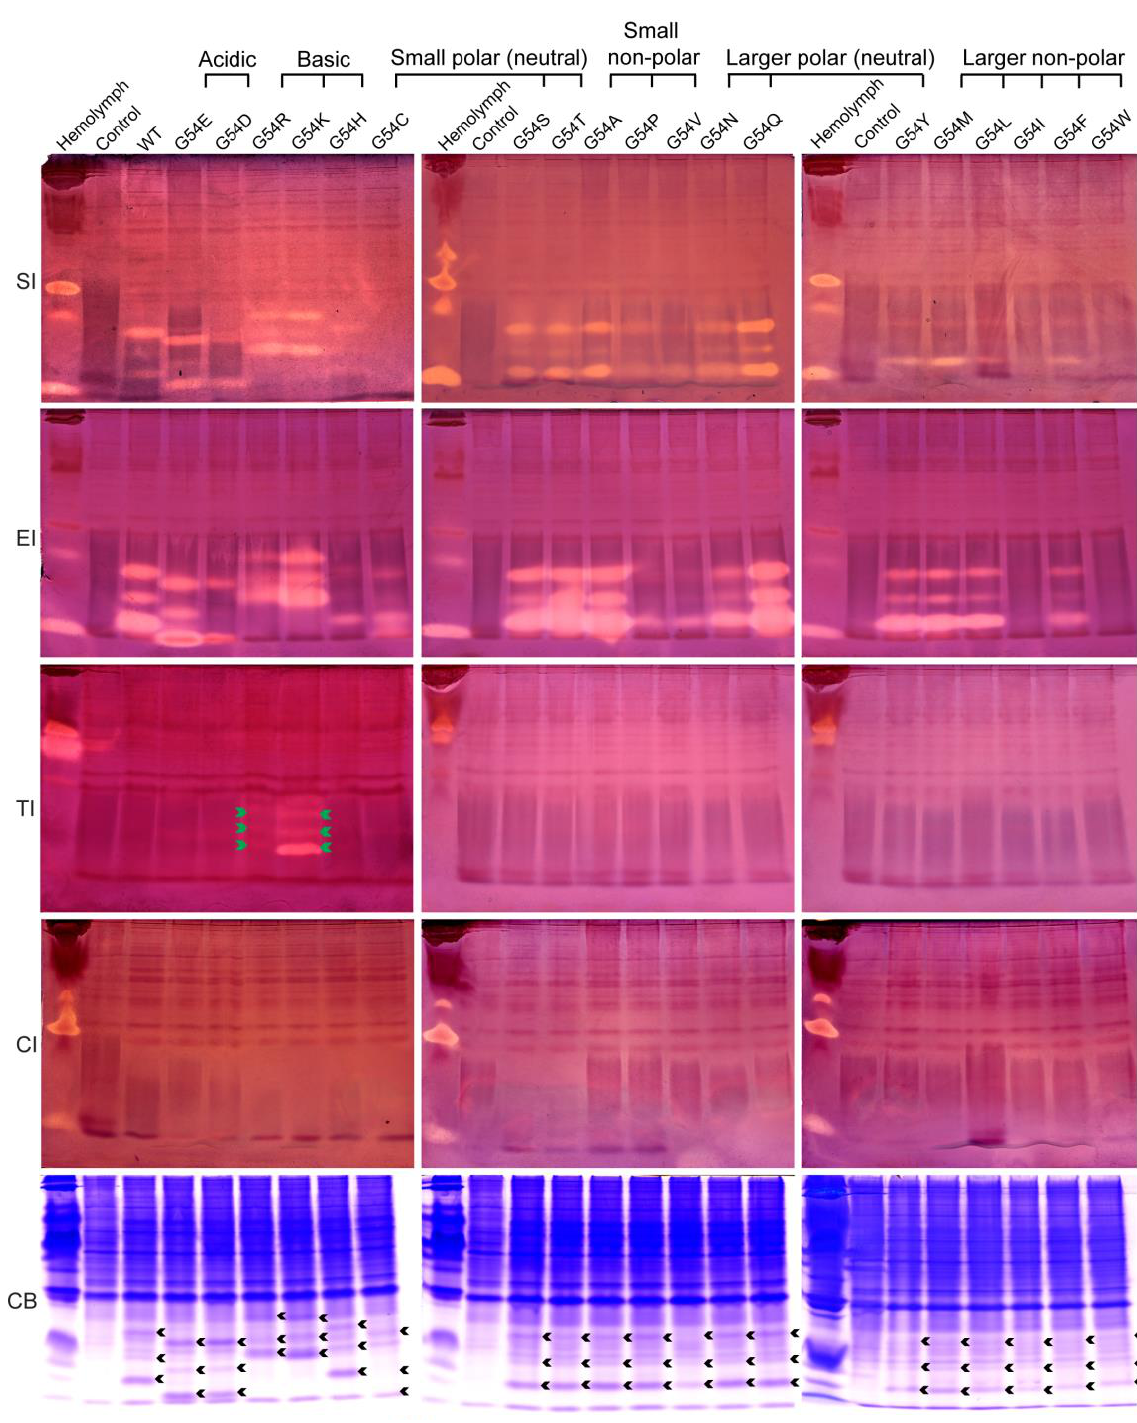
Figure 3. Activity staining of the P1 mutants of BmSPI38 against the serine protease. B. mori hemolymph from day 5 fifth-instar larvae was used as positive control. “Control” represents the lysate supernatant of Origami 2(DE3) cells transformed with the p28 plasmid. “WT” represents the wild-type recombinant BmSPI38 protein. “SI”, “EI”, “TI” and “CI” indicate inhibitory activity against subtilisin, elastase, trypsin, and chymotrypsin, respectively. “CB” indicates protein staining with Coomassie Brilliant Blue R250. Green arrows indicate the inhibitory-active bands of the P1 mutants against trypsin, and black arrows indicate the Coomassie Brilliant Blue-stained protein bands at the position corresponding to the inhibitory-active bands.